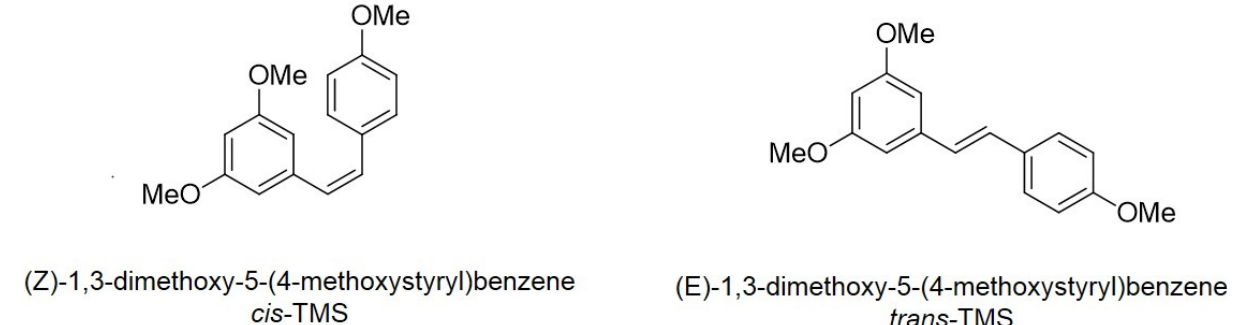
Figure 1 ‒ Chemical structure of cis - and trans